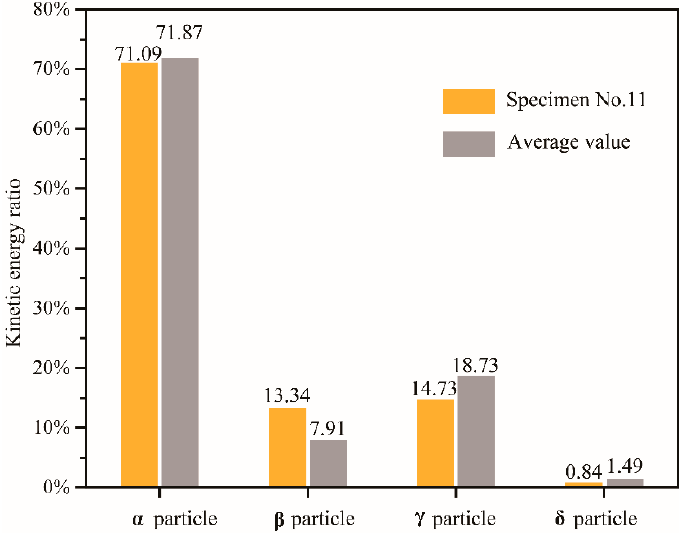
Figure 10. Percentage of the kinetic energy of various particles.